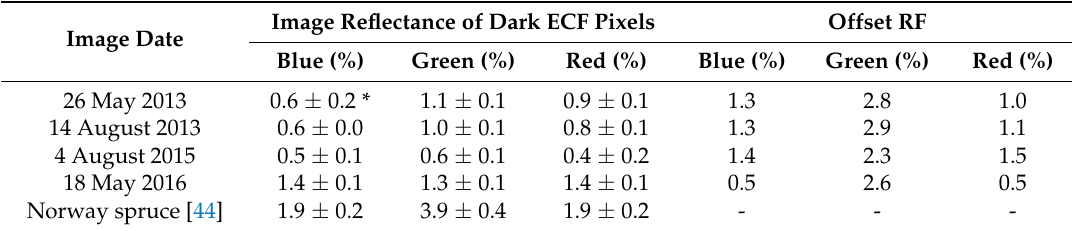
Table 4. RF offset, determined by a comparison of visible spectral reflectance of ECF with Norway spruce measured by the airborne